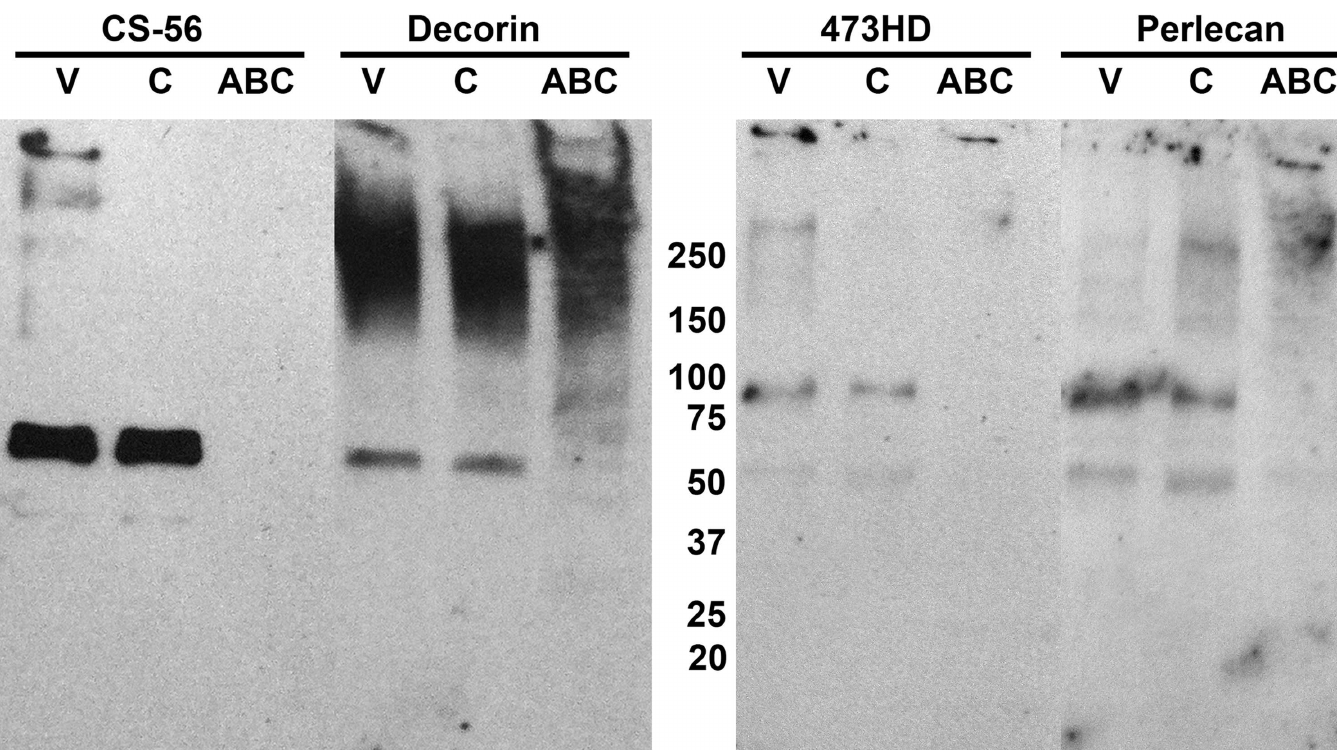
Fig 10. Identification of proteoglycan core proteins and glycosaminoglycan chains in western analysis of enzyme or vehicle treated proteoglycan extract. Proteoglycan enriched nerve extract (PENE) was obtainedas describedin Methods and Materials. Western analysiswas performed using core protein antibodiesagainst decorinand perlecanas well as the glycosaminoglycanantibodiesCS-56 and 473-HD. Vehicle (V) treated PENE providedvarious immunoreactive bands of different molecularweight againstCS-56 and 473-HD.Chondroitinase C (C) treatment eliminated all the highermolecularweight bandsof CS-56 but retaineda CS-56 immunoreactive doubletat M r = 60-65kDand a faint band at 45kD that was observedin the vehicletreated PENE. Meanwhile,chondroitinase ABC (ABC) treatment completelyeliminated CS-56 immunoreactivity from the PENE. Decorinappearedas a very broad band betweenM r = 140-350kD and an isolated 60kD band in the vehicletreated sample. ChondroitinaseC treated PENE did not provide remarkable changesin the decorin immunoreactive bandsbut chondroitinase ABC modifiedthe immunoreactivity slightly by creatinga few bandsat 90kD and 70KD while eliminating the 60kD band. 473-HDimmunoreactivity was observed in severalbands at 300kD, 90kD, 55kD, and at the gel interface of the vehicletreated PENE while chondroitinase C treatment reducedthe intensity of the higherweight bands but retainedthe 90kD and 55kD bands. Chondroitinase ABC treated PENE did not containany 473-HDimmunoreactivity. Perlecanantibody boundto several bandsat M r = 250kD, 165kD, and 155kD as well as a strong band at 90kD and a weak band at 55kD in the vehicletreated PENE. Chondroitinase C treated PENE increasedthe intensity of perlecan immunoreactivity in the M r = 250kD band whilereducingthe intensity of the 165kD and 155kD but retainedthe 90kD and 55kD band. Interestingly, chondroitinase ABC treatment did not modify the highermolecularweight bands of perlecan but did remove the 90kD and 55kD